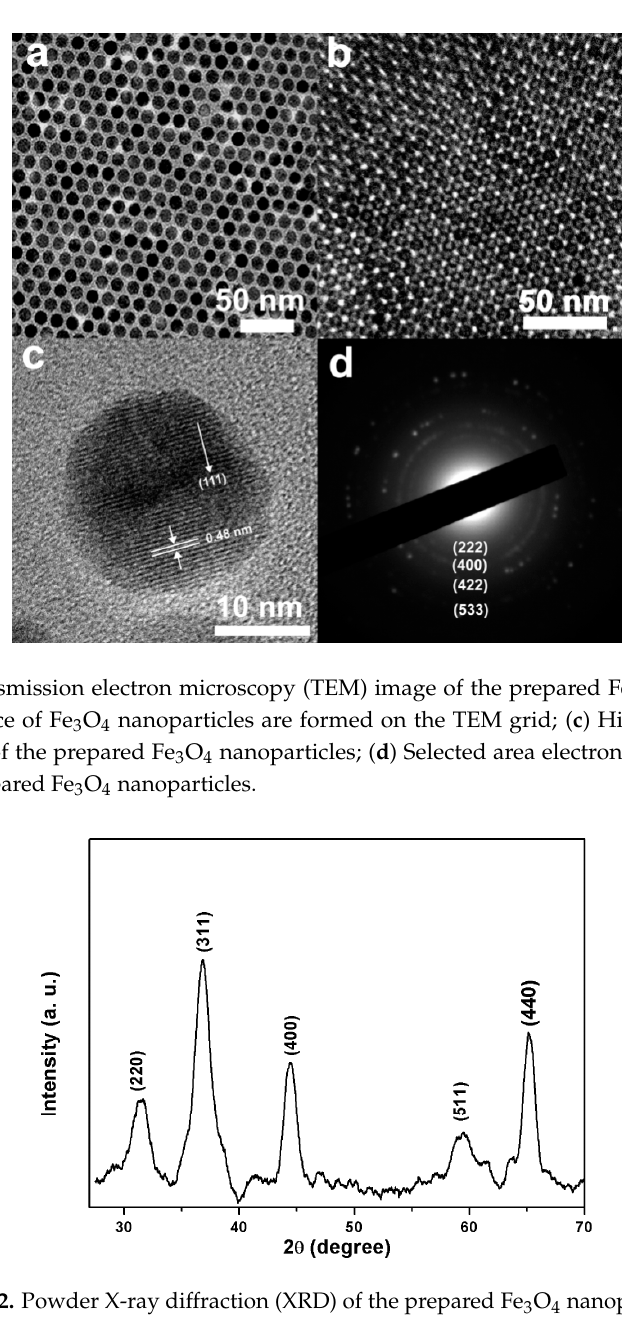
Figure 2. Powder X ‐ ray diffraction (XRD) of the prepared Fe 3 O 4 nanoparticles.